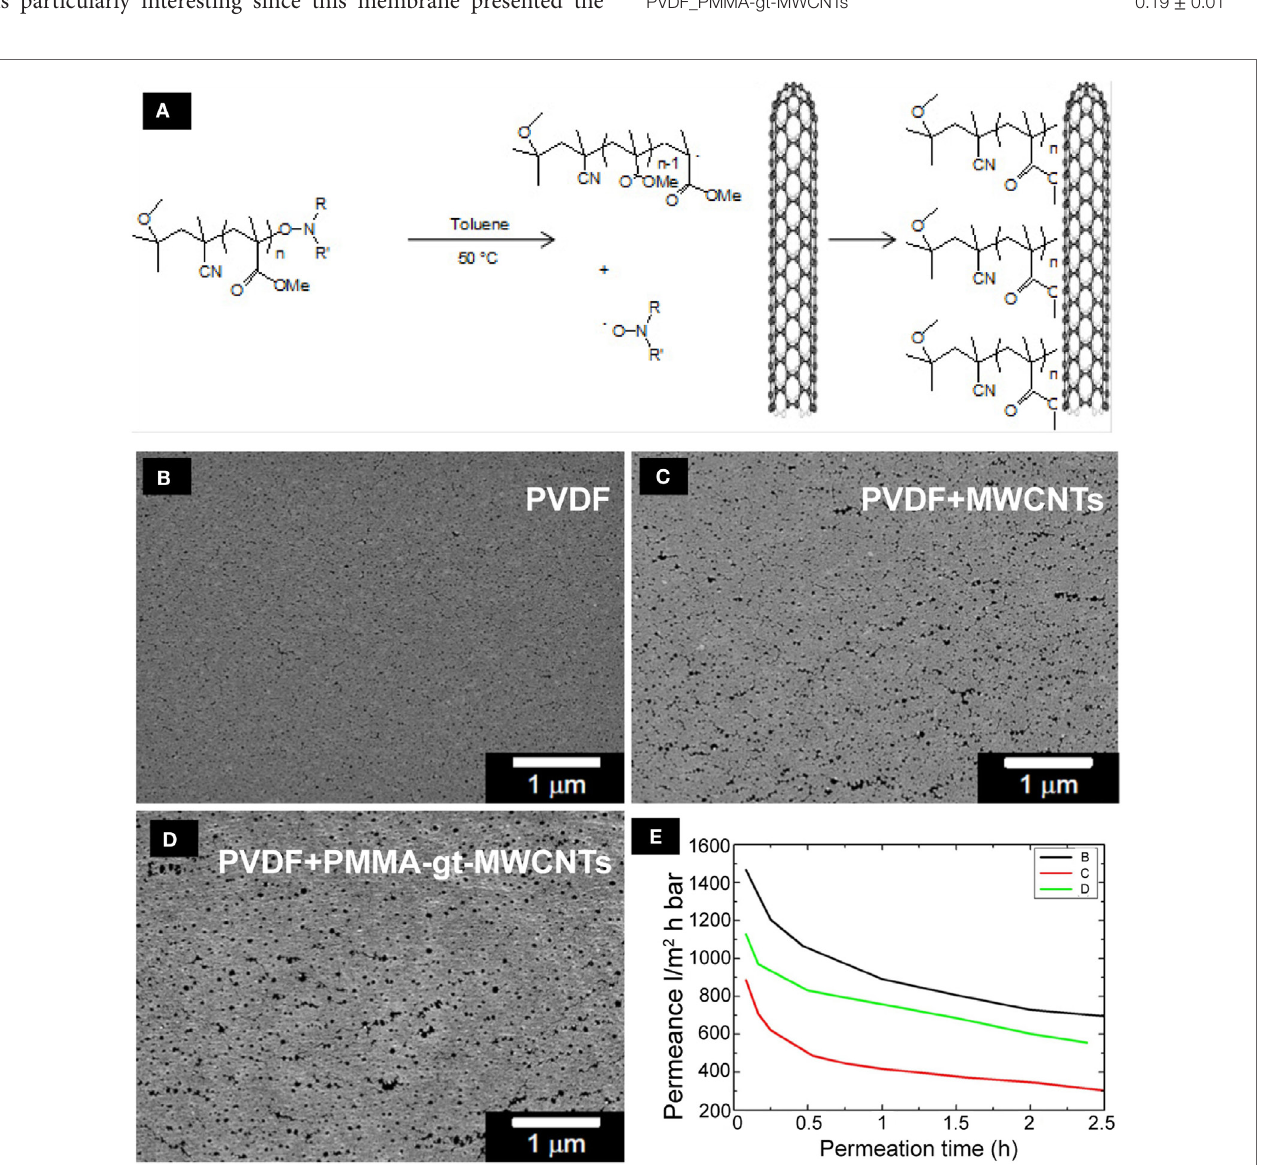
FigUre 7 | The functionalization and distribution of MWcnTs on PVDF membranes . Schematic diagram of the grafting of alkoxyamine end-capped PMMA chains onto MWCNTs (a) . SEM microphotographs of the top view of pristine PVDF membranes (B) , PVDF membranes + MWCNTs (c) , and PVDF membranes + PMMA-gt-MWCNTS (D) are shown. The PVDF layer has been loaded with 2 wt% of MWCNTs with and without grafted polymers. The graph (e) shows water permeation measurements of the PVDF membranes.